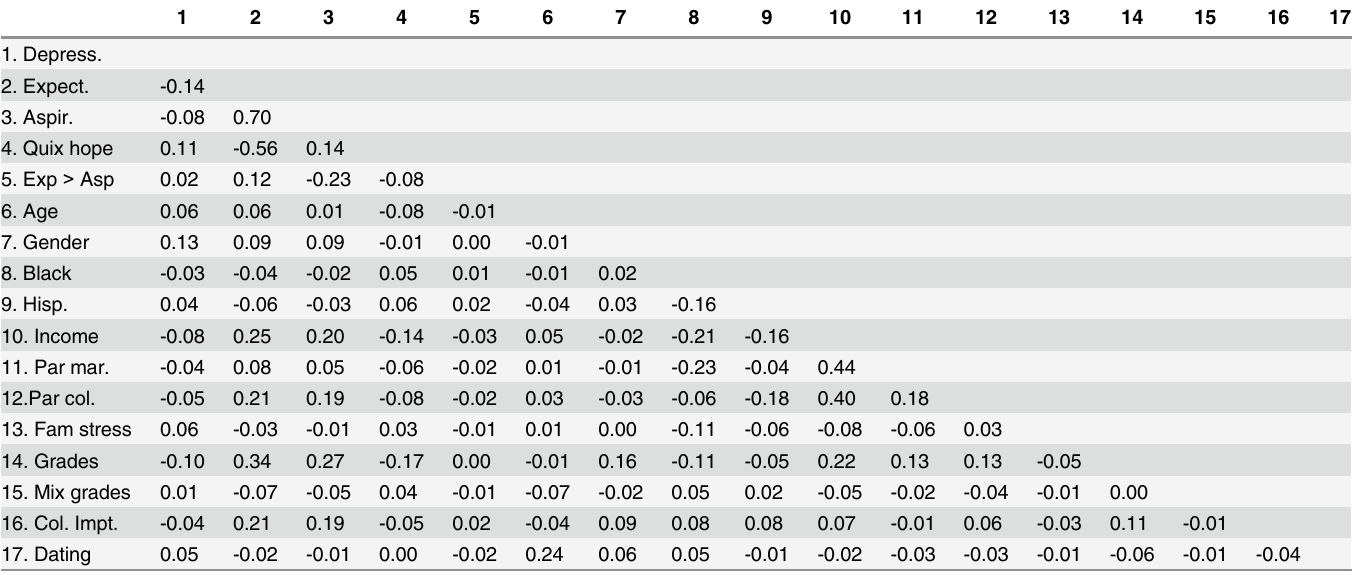
Table 5. Bivariate correlations between the variables in the model (Study 2, Time